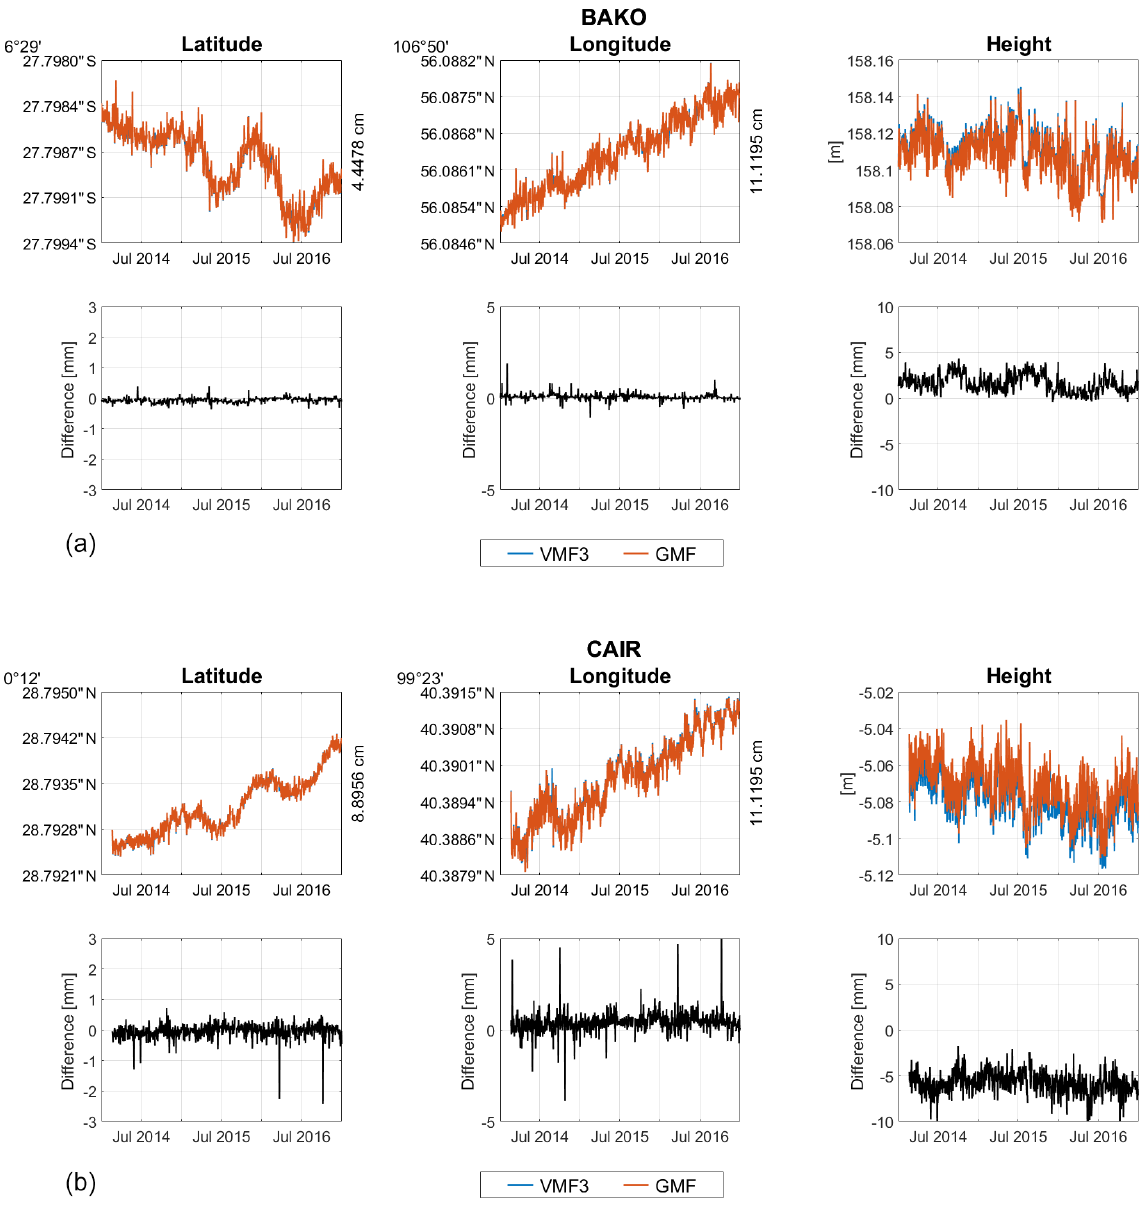
Figure 2. Estimated coordinates from VMF3 and GMF and their differences for station BAKO (a) and CAIR (b) . On the right side of the latitude and longitude plot, max-min value in cm is